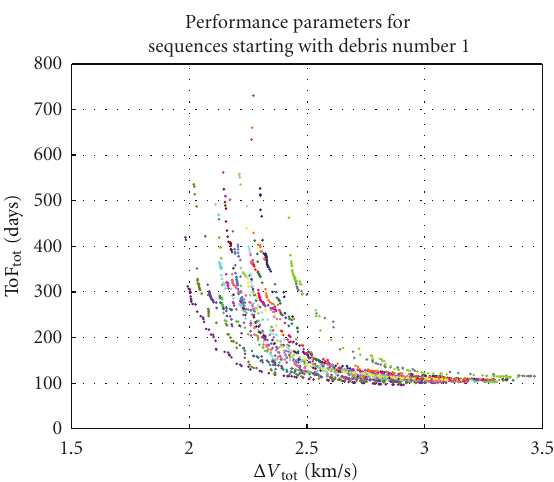
Figure 11: Pareto fronts for sequences starting with debris nr. 1.